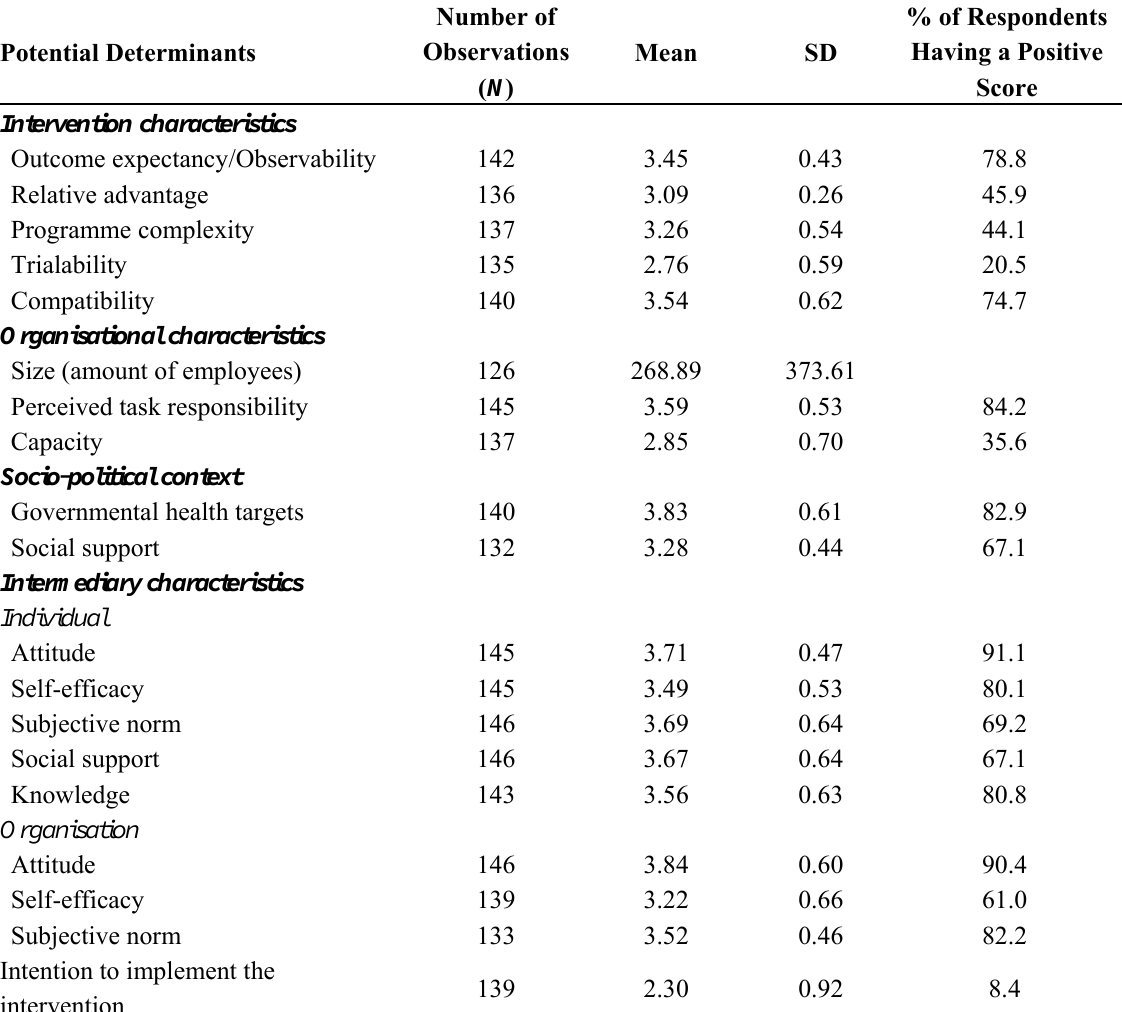
Table 2. Mean scores and standard deviation (SD) for the characteristics of the intervention, the organization, the socio-political context and of the intermediary. Number